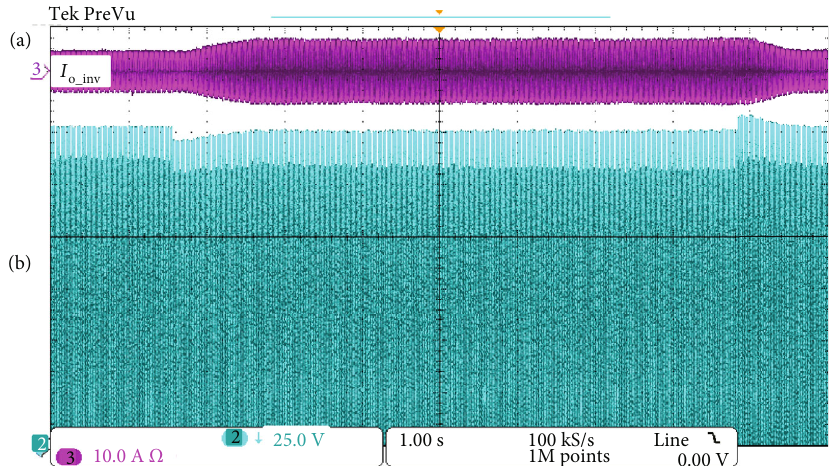
Figure 14: System response under transformer voltage variation (decrement): (a) current in residence 11 ( I residence 11 ( V , 25V/div). Time 1 11